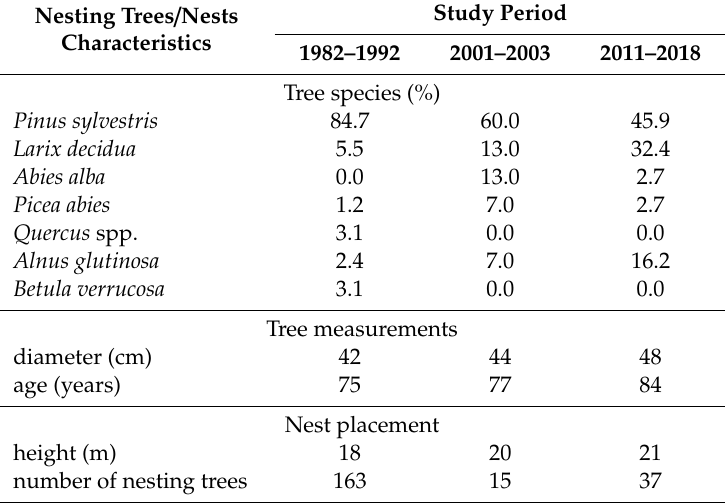
Table 4. The characteristics of the nesting trees of goshawk in the area of study (central Poland, vicinity of Rog ó w village, Experimental Forest Station of Warsaw University of Life Sciences) in the three compared breeding periods: The data are for 1982–1992 [29], 2001–2003 [55], and 2011–2018, the current